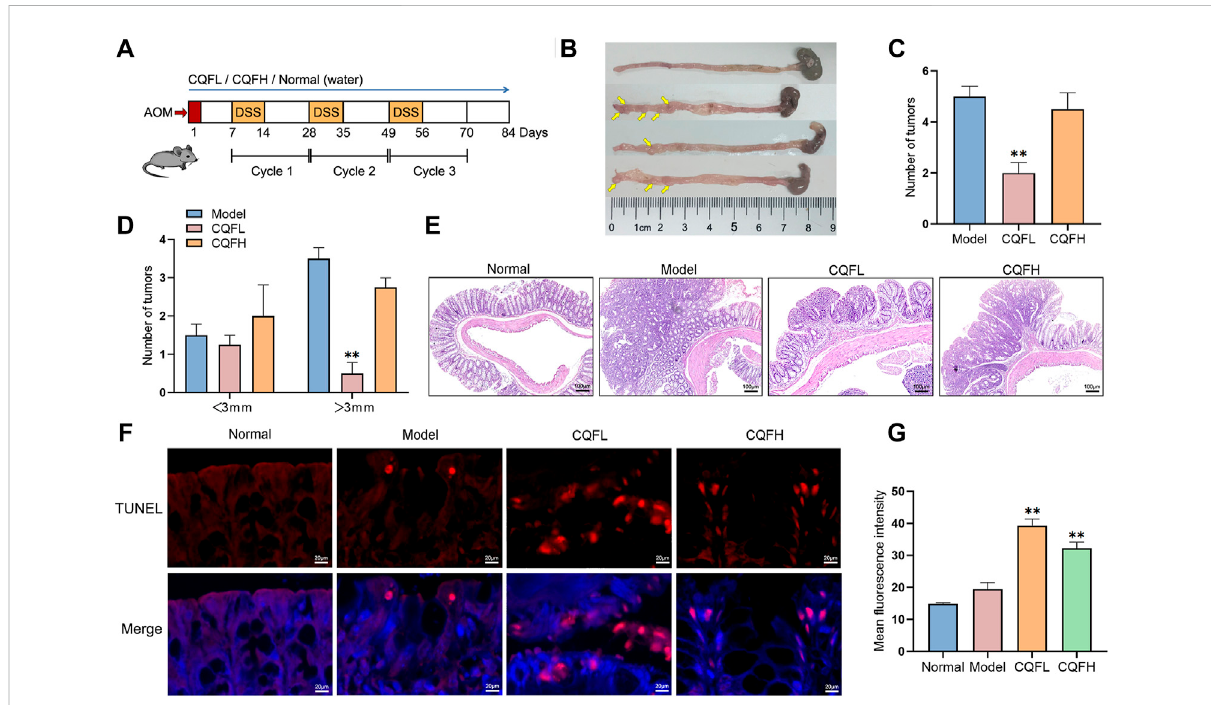
FIGURE 4 Effect of CQF on colitis-associated cancer in AOM/DSS-treated mice. (A) Schematic diagram of the AOM/DSS model. (B) Photographs of mouse colon tissues, with tumors indicated by yellow arrows. (C,D) Number and size of colorectal tumors in mice (n = 6 each). (E) H&E staining of colon tissues. (F) TUNEL staining of colon tissues. (G) Mean fl uorescence intensity, calculated from six randomly selected localized areas in each group. Results are expressed as mean ± SEM. *p < 0.05 , **p < 0.01 , compared with AOM/DSS-treated mice. ### p < 0.01, compared with the normal